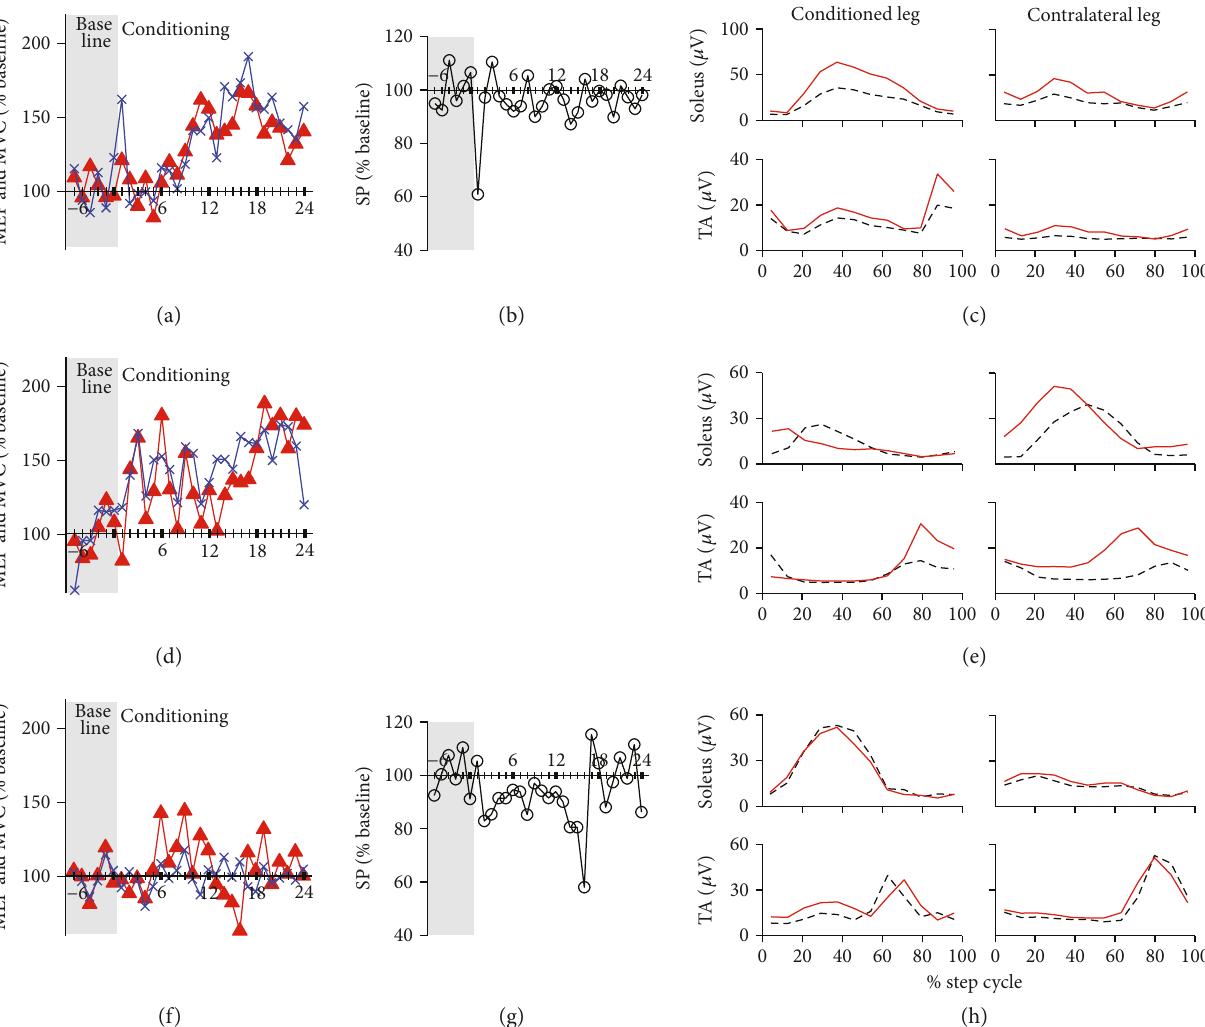
Figure 4: Changes in the TA MEP, MVC, and SP over the course of study and bilateral locomotor EMG in subjects B, C, and D. (a, b, c) Subject B. (a) Mean MEP size ( fi lled triangle) and MVC (cross) in 6 baseline (shaded part of the panel) and 24 conditioning sessions. (b) Mean SP duration. (c) Recti fi ed locomotor EMG activity in soleus and TA of both legs before (black) and after (red) conditioning. After successful MEP up-conditioning, locomotor EMG modulation increases in TA and soleus of both legs; not only the conditioned TA but also the soleus burst amplitude increased. (d, e) Subject C. (d) Mean MEP size and MVC in 6 baseline and 24 conditioning sessions. (e) Recti fi ed locomotor EMG activity in soleus and TA bilaterally, before and after conditioning. After successful MEP up-conditioning, TA EMG burst amplitude increased in both legs. SP duration could not be measured in this subject. (f, g, h) Subject D. (f) Mean MEP size and MVC in 6 baseline and 24 conditioning sessions. (g) Mean SP duration. (h) Recti fi ed locomotor EMG activity in soleus and TA bilaterally, before and after conditioning. In this subject, unlike subjects A – C, MEP up-conditioning had no signi fi cant e ff